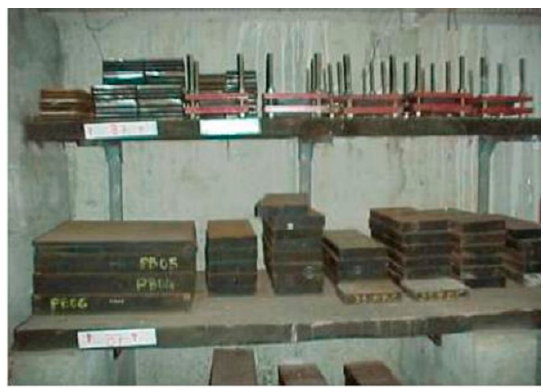
Figure 3. Neoprene (elastomer) pads stored in situ at the Cruas nuclear power plant for periodic testing of aging effects [9].